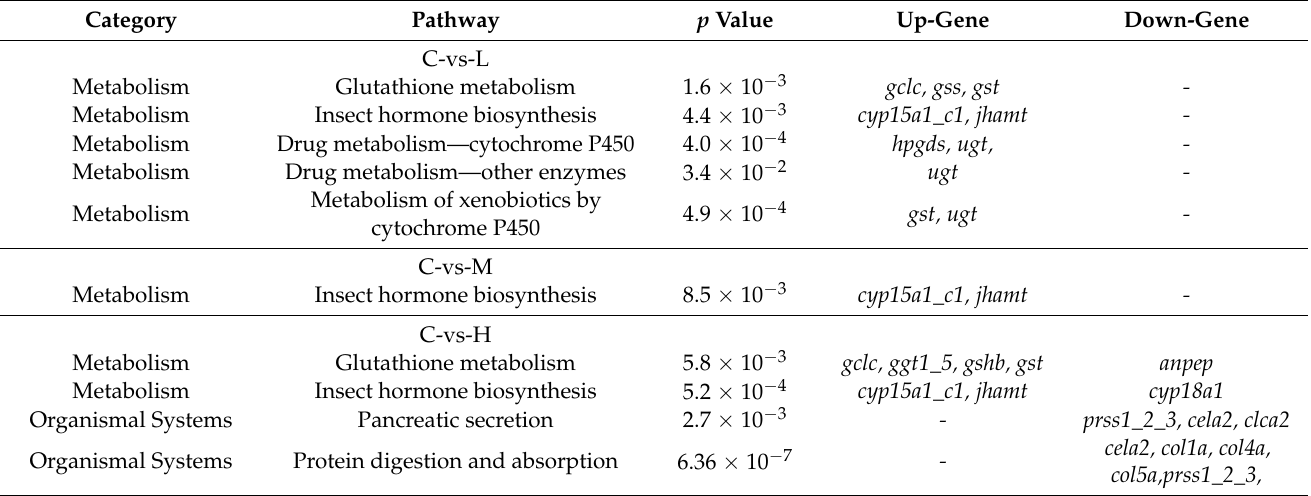
Table 1. List of crucial biological pathways disrupted by PRA exposure ( p <